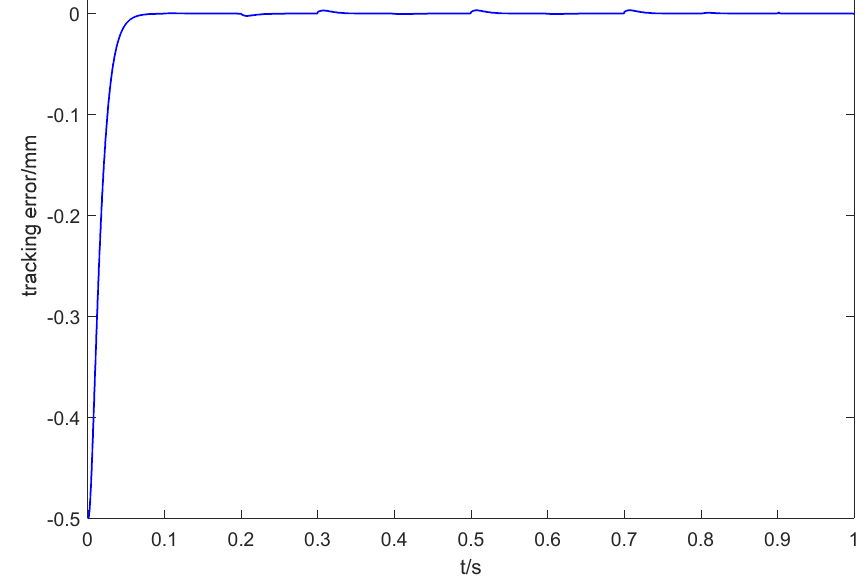
Figure 8. Tracking error curve.